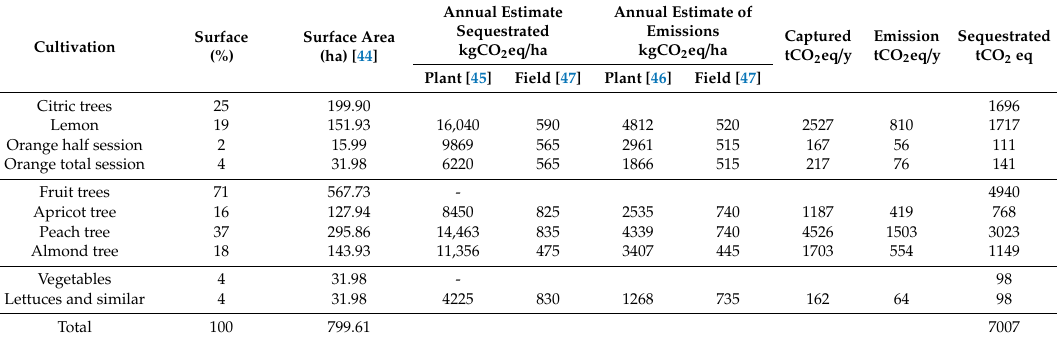
Table 6. Summary of the footprint of CO 2 eq sequestration by crops. Source: Based on [44–47].